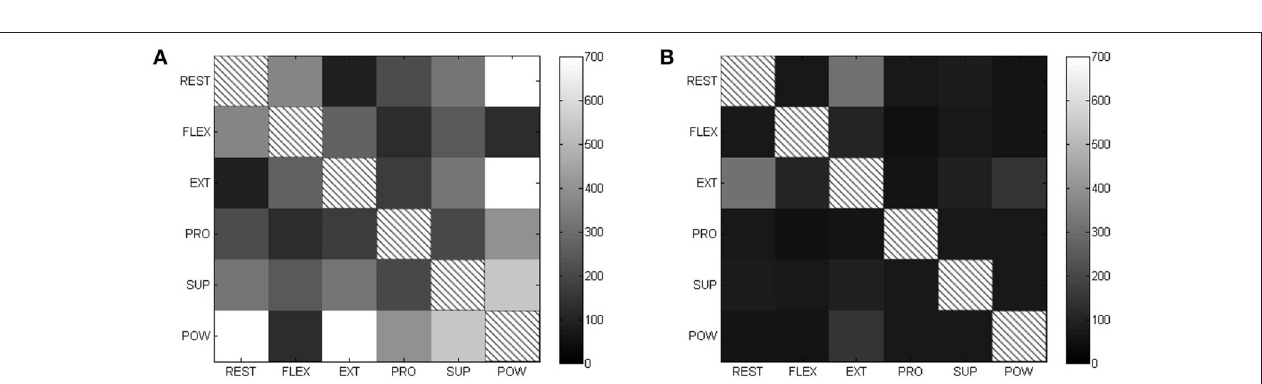
FIGURE 8 | Fisher’s Index matrices for each type of sensor (higher is better). (A) FSR Fisher’s index. (B) EMG Fisher’s index.